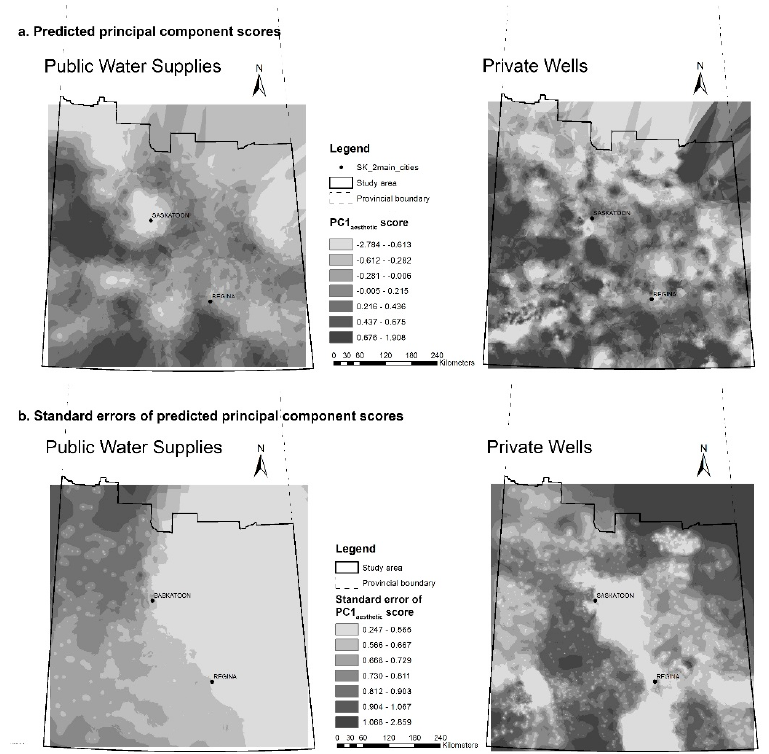
Figure A12. ( a ) Predicted PC1 aesthetic scores for public water supplies and private wells in study area; and ( b ) the corresponding prediction standard errors.